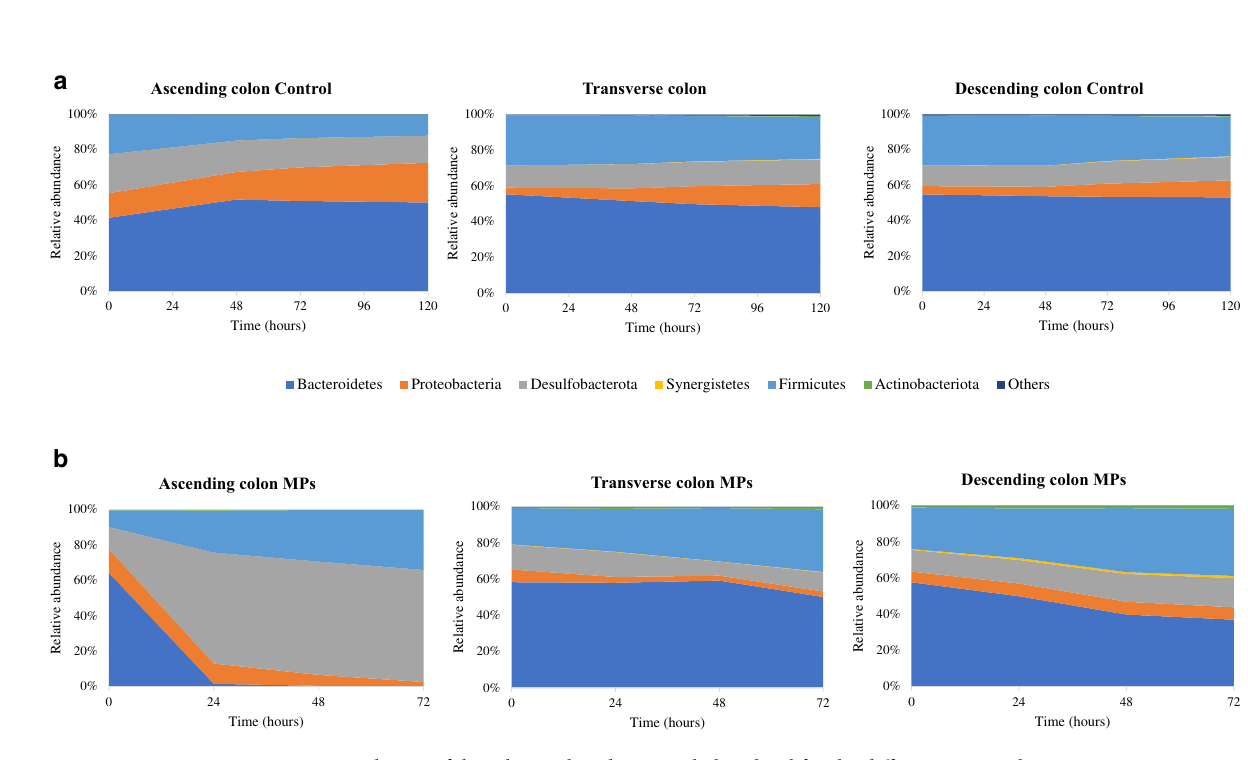
Figure 6. Evolution of the relative abundance at phylum level for the different simgi colonic compartments during colonic fermentation in volunteer 2. ( a ) show results for control period while ( b ) show the effect of MPs intervention. Graphs include the taxa with a relative abundance > 0.5% in at least one of the time points of one simgi colonic